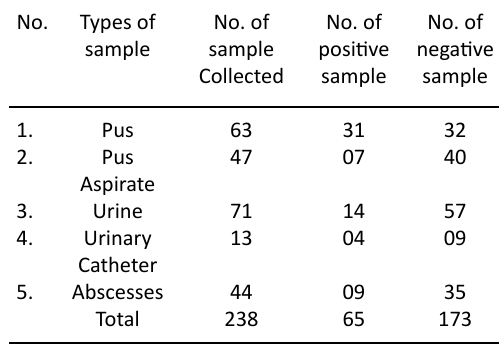
Table 2. Demographic data of clinical specimens